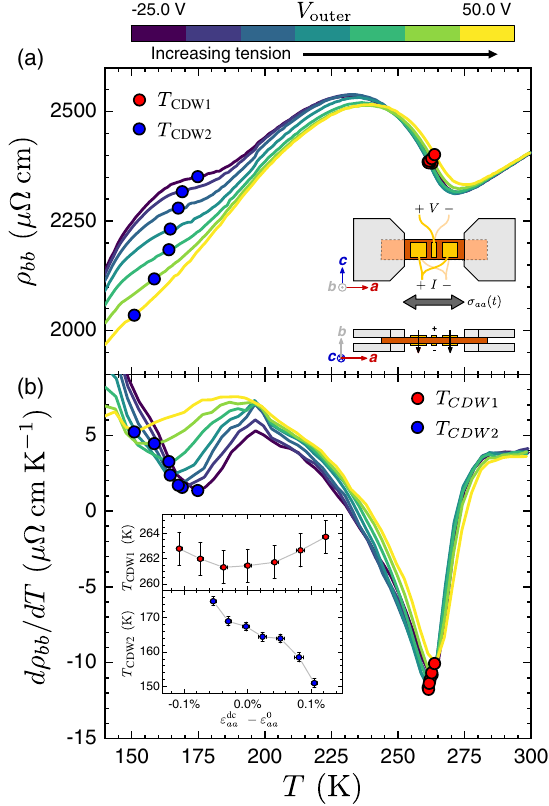
FIG. 5. Out-of-plane resistivity ρ in ErTe 3 . Panel (a) shows bb the resistivity traces for a series of PZT voltages. Inset: top and side view schematics of the contact geometry used in this experiment. Current is passed into the sample through the larger, outer two contacts on both the top and bottom of the crystal, and the smaller center pads are used to detect the voltage. Temper- ature derivatives of the resistivity traces are shown in (b). The minima of the derivative traces correspond to the critical temper- atures. Inset of (b): T and T plotted as a function of CDW 1 CDW 2 strain. The lack of a maximum in T corresponding to the CDW 2 minimum in T and the switch between the two cases is CDW 1 attributed to an underestimate of the tensile stress arising from mismatched thermal expansion of the sample and stress